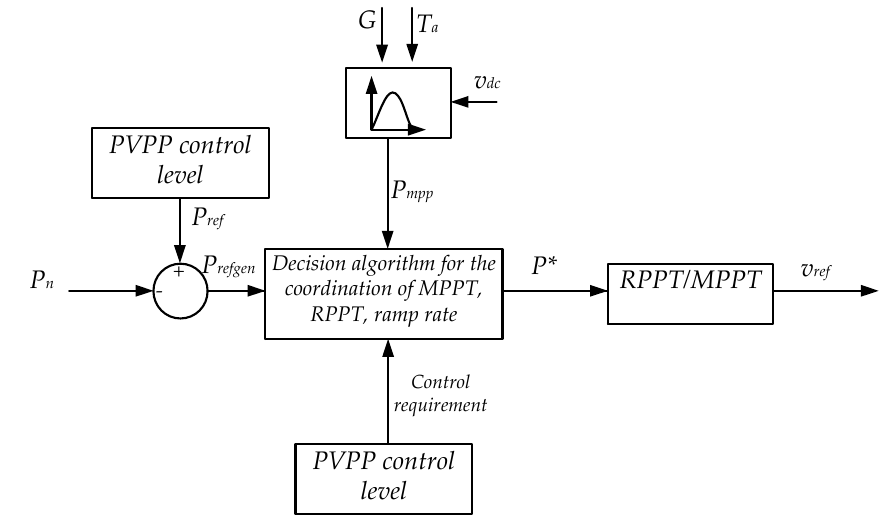
Figure 13. Control scheme for control of active power in PV